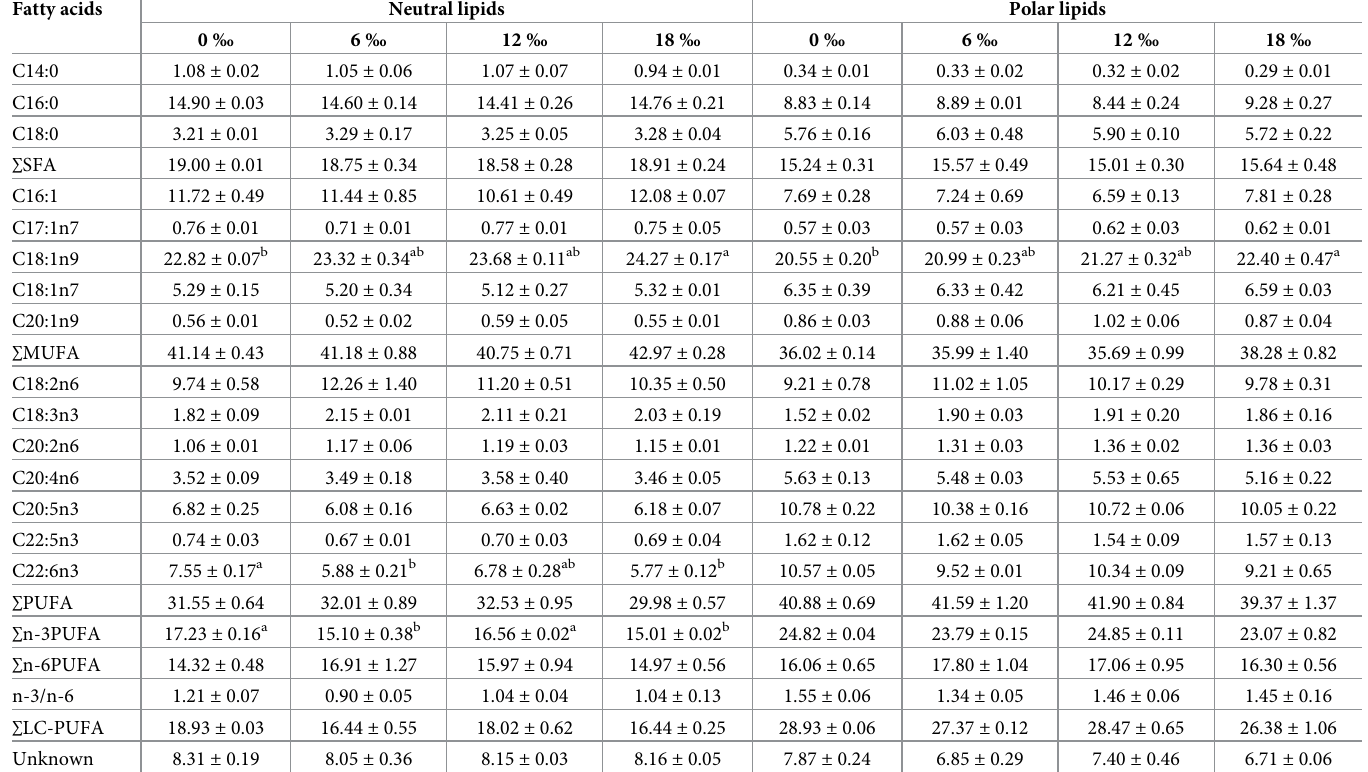
Table 3. The principal fatty acid profiles (% total fatty acids) of the neutral lipids and polar lipids in the ovaries of adult female E . sinensis . Fatty acids